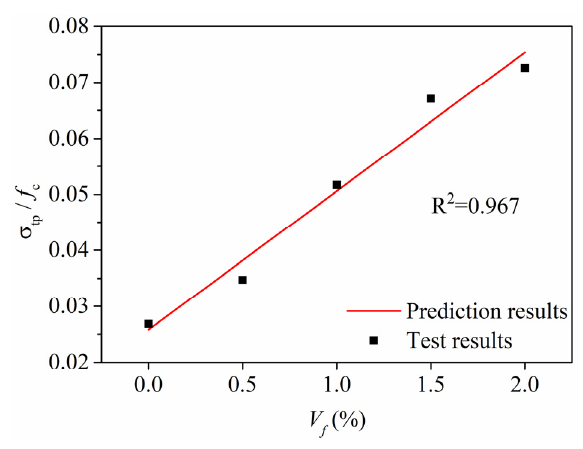
Figure 19. Relationship between σ tp / f c and V f .